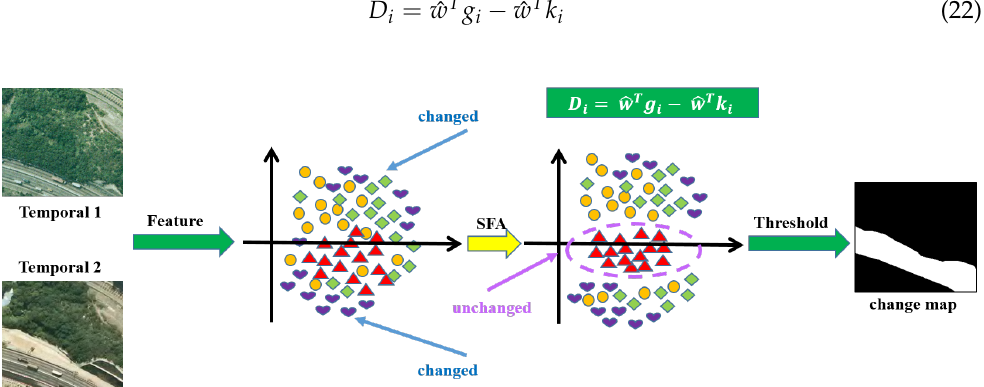
Figure 1. The schematic of slow feature analysis for remote sensing change